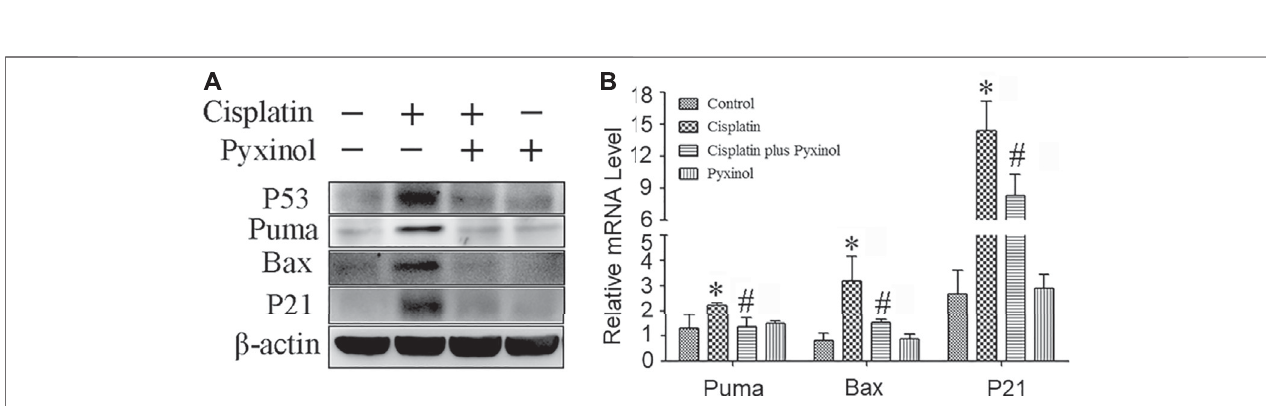
FIGURE 4 | Effects of pyxinol on cisplatin-induced renal tubular cell apoptosis. The paraf fi n kidney section was stained with TUNEL staining, and the slides were observedusingaconfocal fl uorescencemicroscope,inwhichatleast2,000tubulecells(bluecells)wererandomlyexaminedtoquantifytheratioofapoptoticcells(green cells). (A) Controlgroup; (B) Cisplatingroup; (C) Cisplatinpluspyxinolgroup; (D) Pyxinolgroup.Theapoptoticcellswereindicatedwithredarrows. *p < 0.05,compared with the control group; #p < 0.05, compared with the cisplatin group.